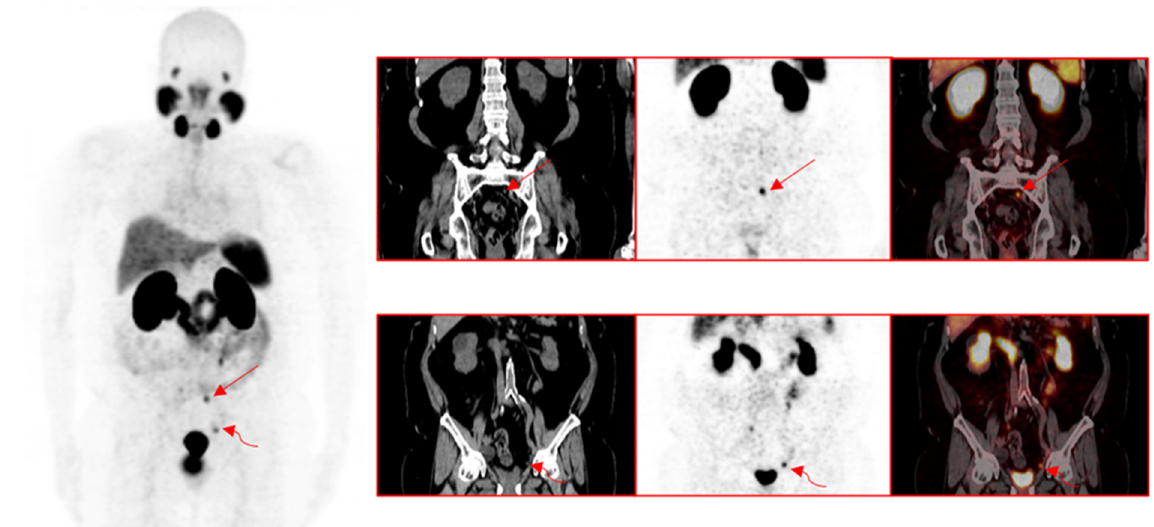
Figure 3. A 63-year-old male with a history of radical prostatectomy for adenocarcinoma of the prostate, Gleason 4+4. Ga-PSMA-11 PET/CT was requested for localization of disease recurrence at a serum PSA of 0.54 ng/mL. Images show intense tracer uptake in a subcentimeter left presacral node (straight arrows) and a subcentimeter left external iliac node consistent with the sites of prostate cancer recurrence.